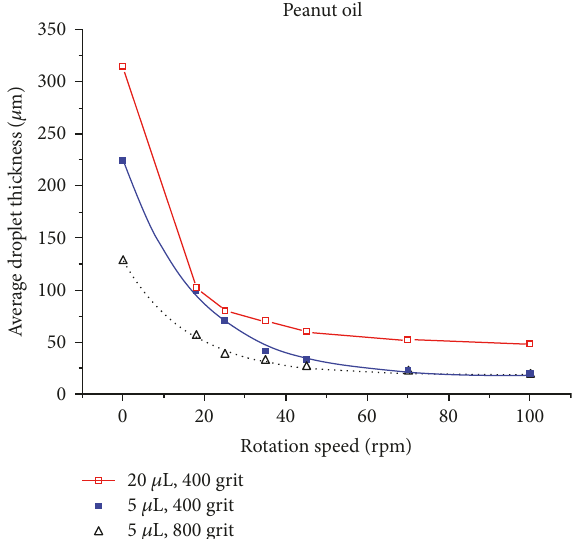
Figure 6: Average droplet thickness of peanut oil with volume of 20 μ L or 5 μ L, placed on the support polished with sandpaper of 400grits/mm and 800 grits/mm. For 5 μ L droplets, the data are fi tted